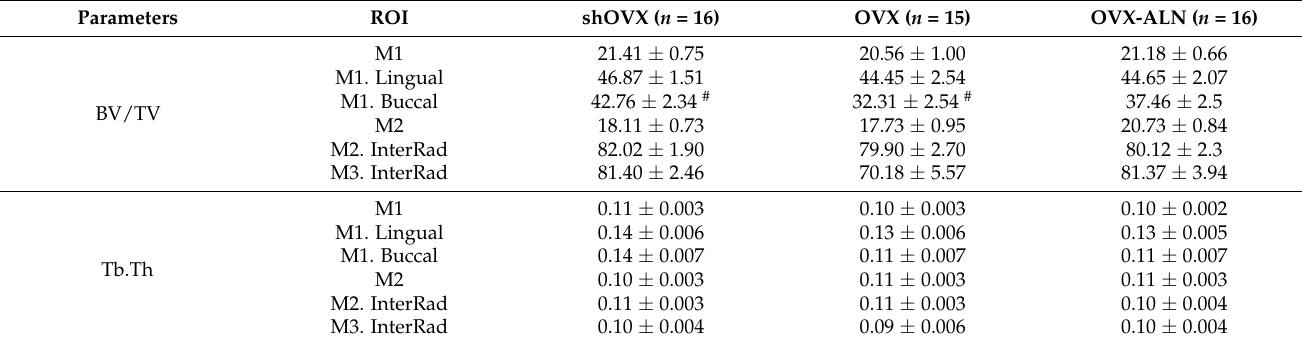
Table 1. Morphometric indices corresponding to the trabecular bone micro-architecture in the molar region of the mandible ( n = 47).